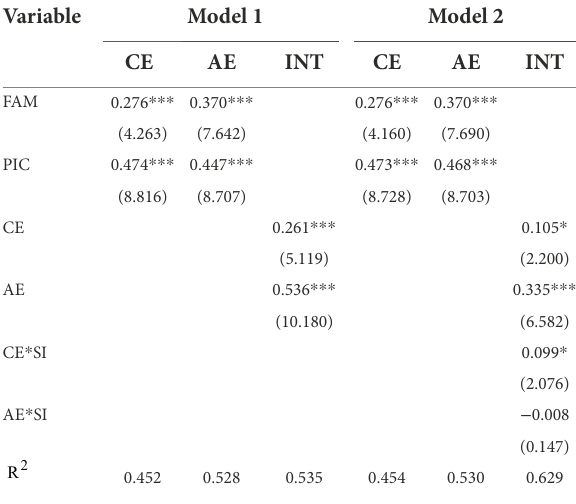
TABLE 6 Regression results for moderation effects.